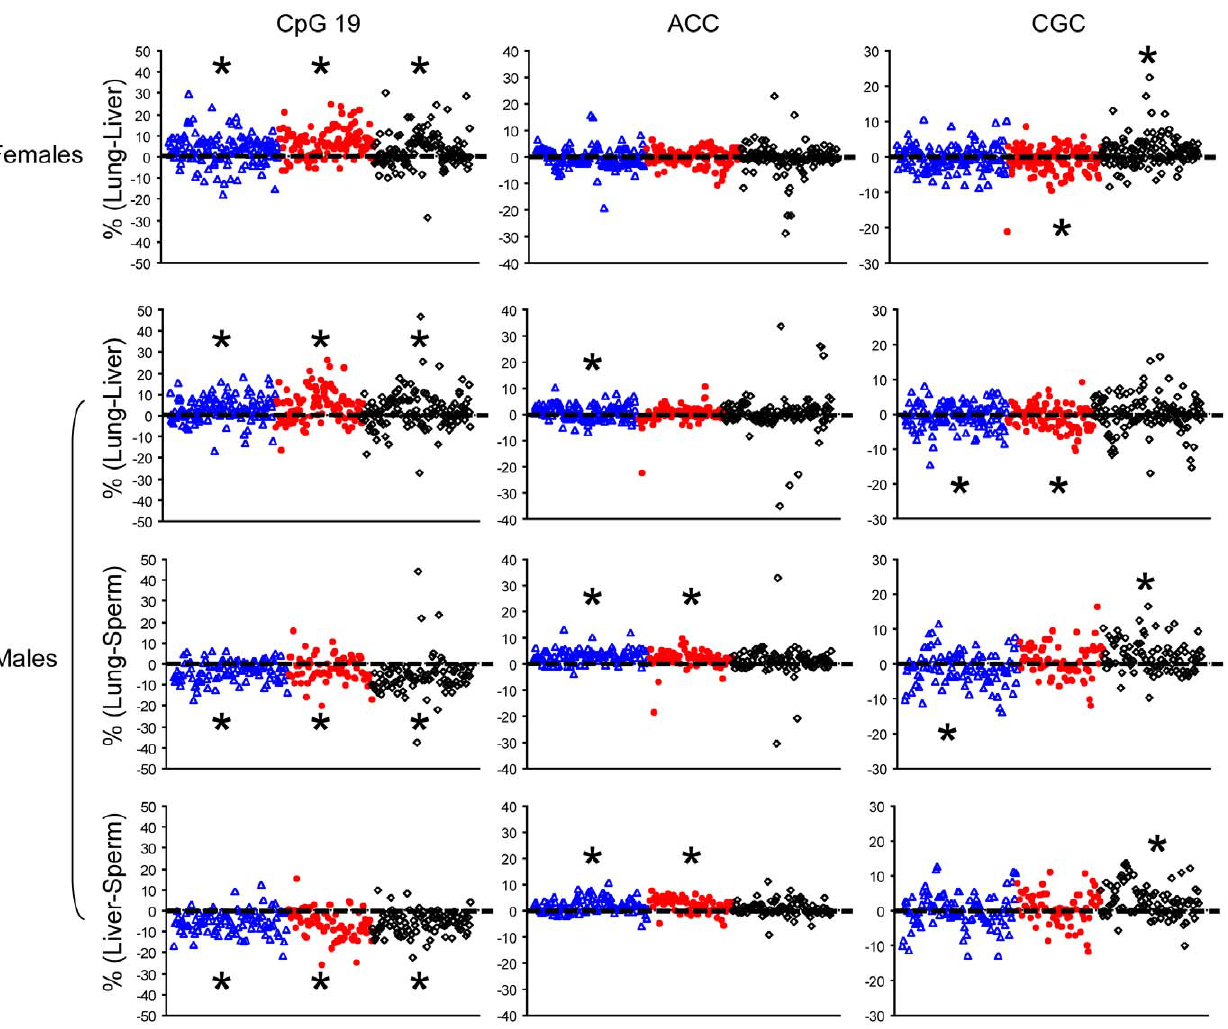
Figure 4. Genetic and epigenetic differences among adult offspring tissues. The arithmetic differences (y-axis) of rDNA sequence variant frequency (%, ACC and CGC) and CpG19 methylation (%) between two 6-week adult tissues of the same animals were plotted. Deviations of the differences from a reference line, of an identity with zero difference, were frequently detected in 3 paternal treatment lineages (blue: acidic saline; red: Cr; black: untreated). *Denotes statistical significance in paired difference between tissues of the same mice in each treatment group and identifies positive/negative mean differences by its location above/below the zero reference line (see Data S3 for p values). The standard error lines are omitted to provide clear view of the scatter